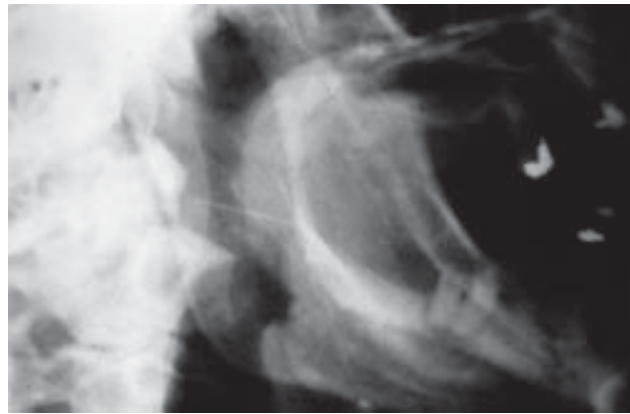
Figure 1. Lateral skull radiograph showing the needle under the lingula.